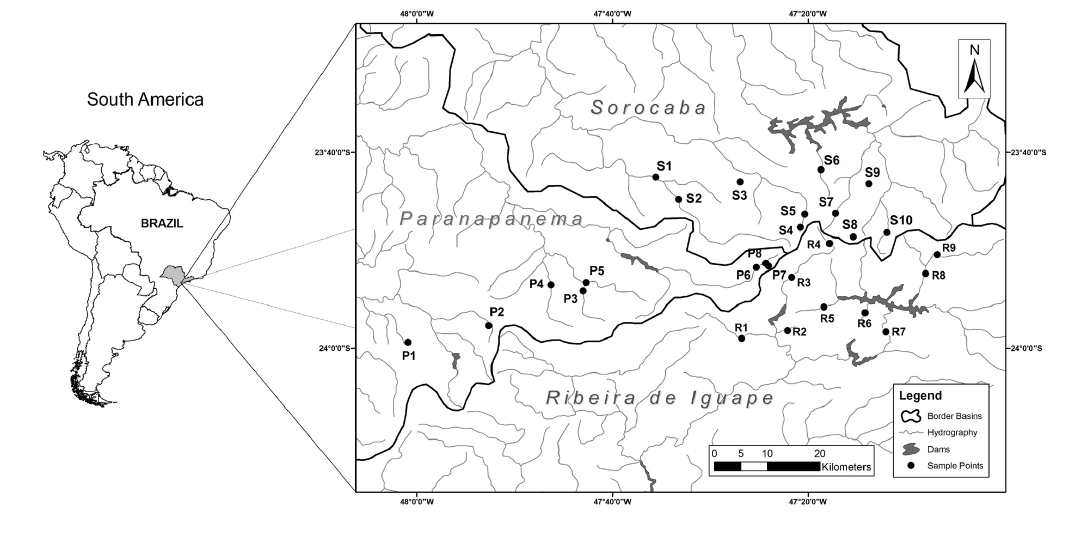
Figure 1. Limits of the Sorocaba, Paranapanema and Ribeira de Iguape river basins and streams